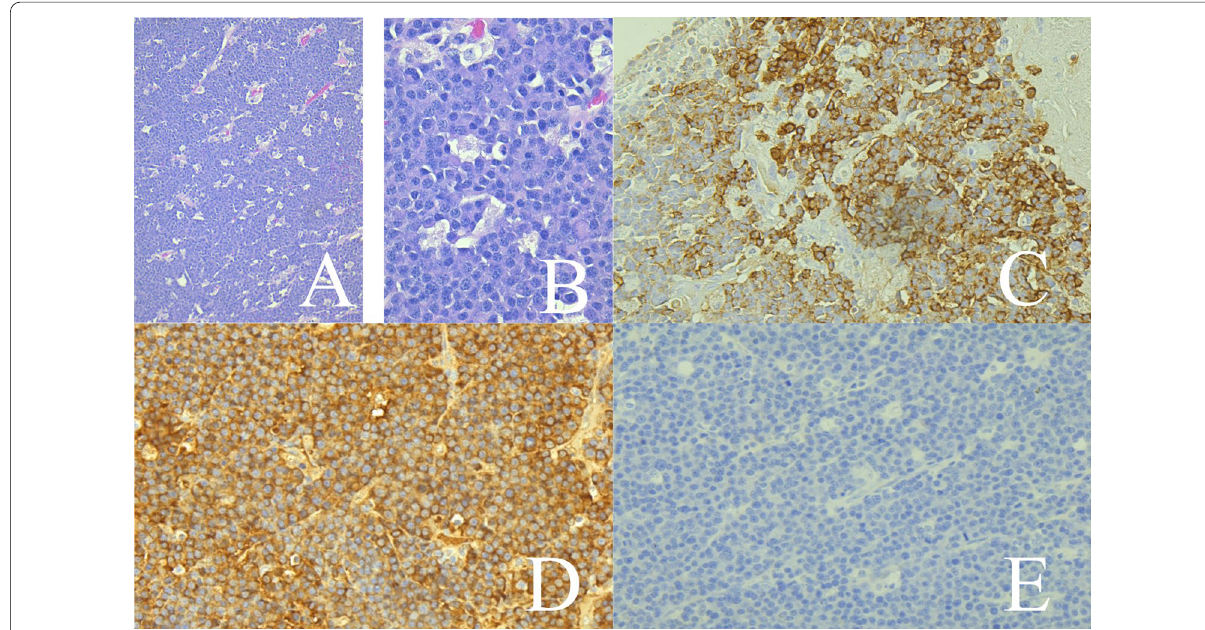
Fig. 5 Histological slides showing diffuse sheets of tumour cells ( A ) and round eccentric nuclei with abundant eosinophilic cytoplasm ( B ), consistent with plasmacytoid neoplasm. Picture C shows cytoplasmic and membranous staining for CD138, confirming plasma cells. There was restriction to Kappa light chain staining ( D ), but not to Lambda ( E ). This confirms a neoplastic plasma cell